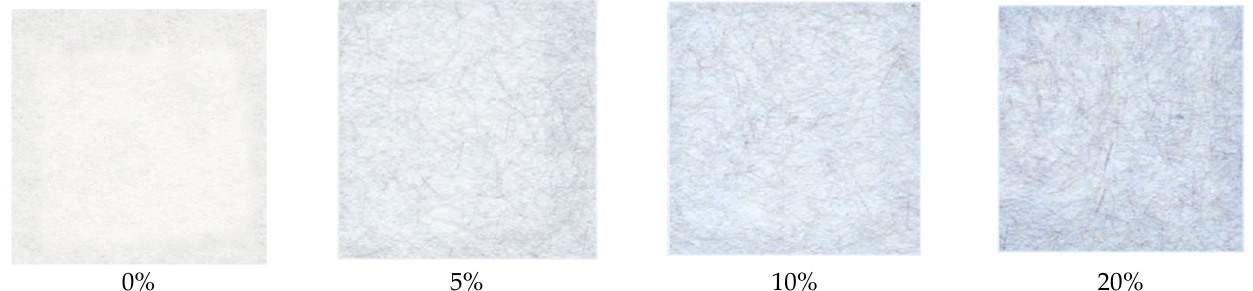
Figure 1. Comparison of paper samples irradiated with the dose of 5 J/cm 2 of UVC light with different contents of the PAN–PDA dopant (non-refined paper).